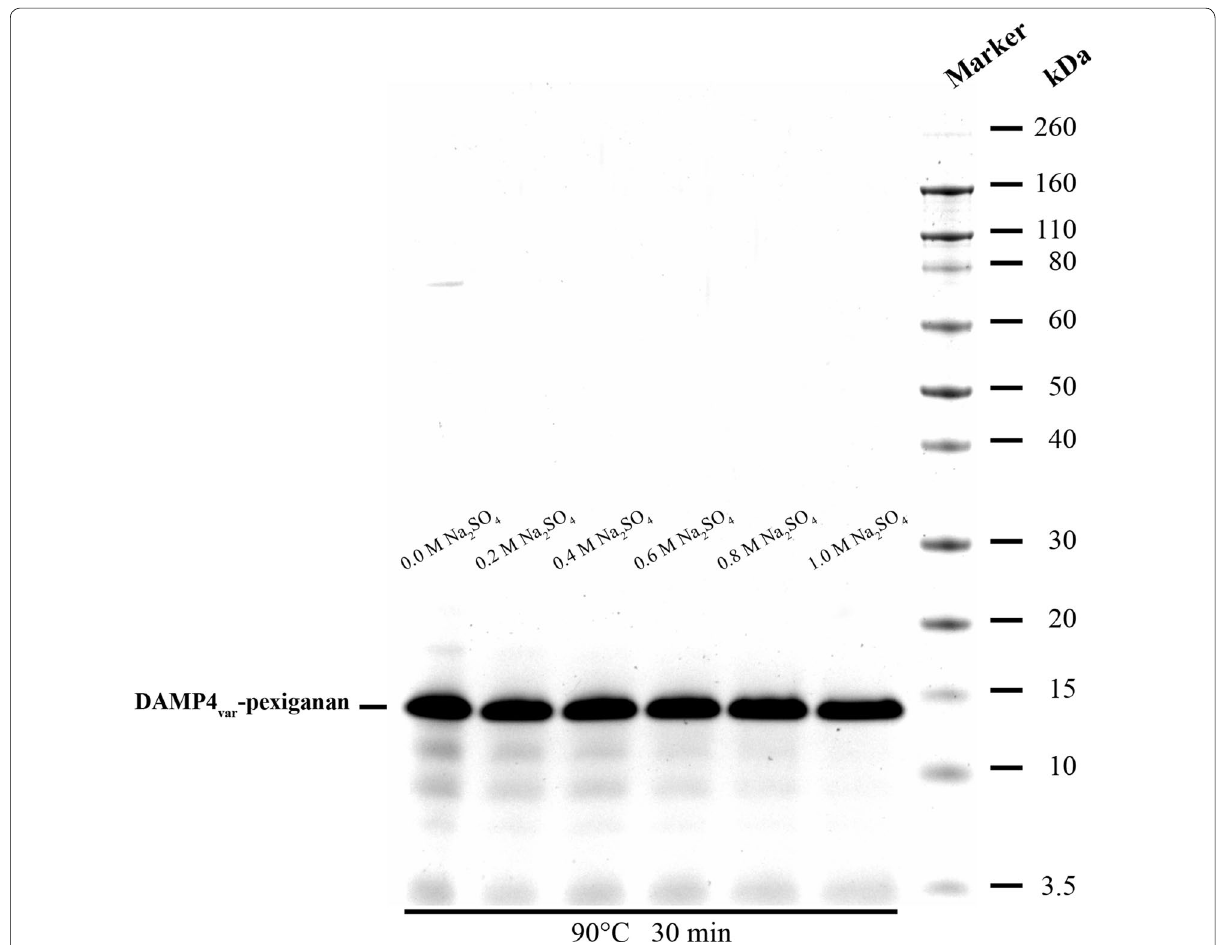
Fig. 3 Effect of Na 2 SO 4 concentrations (0–1 M) on the precipitation of protein contaminants at 90 °C as shown by SDS–PAGE